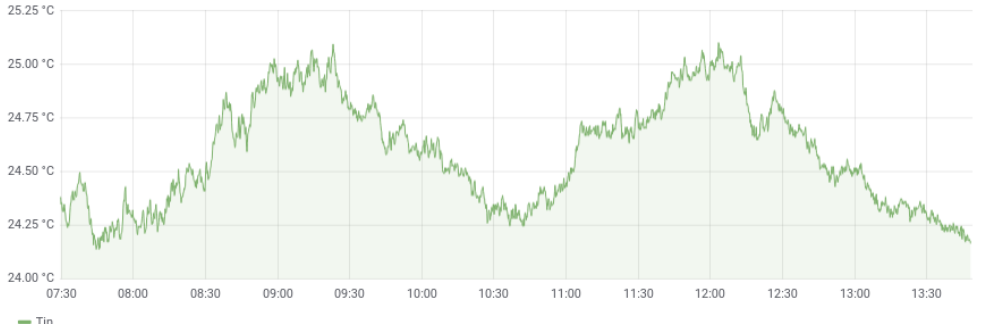
Figure 9. Water inlet temperature ( T in )